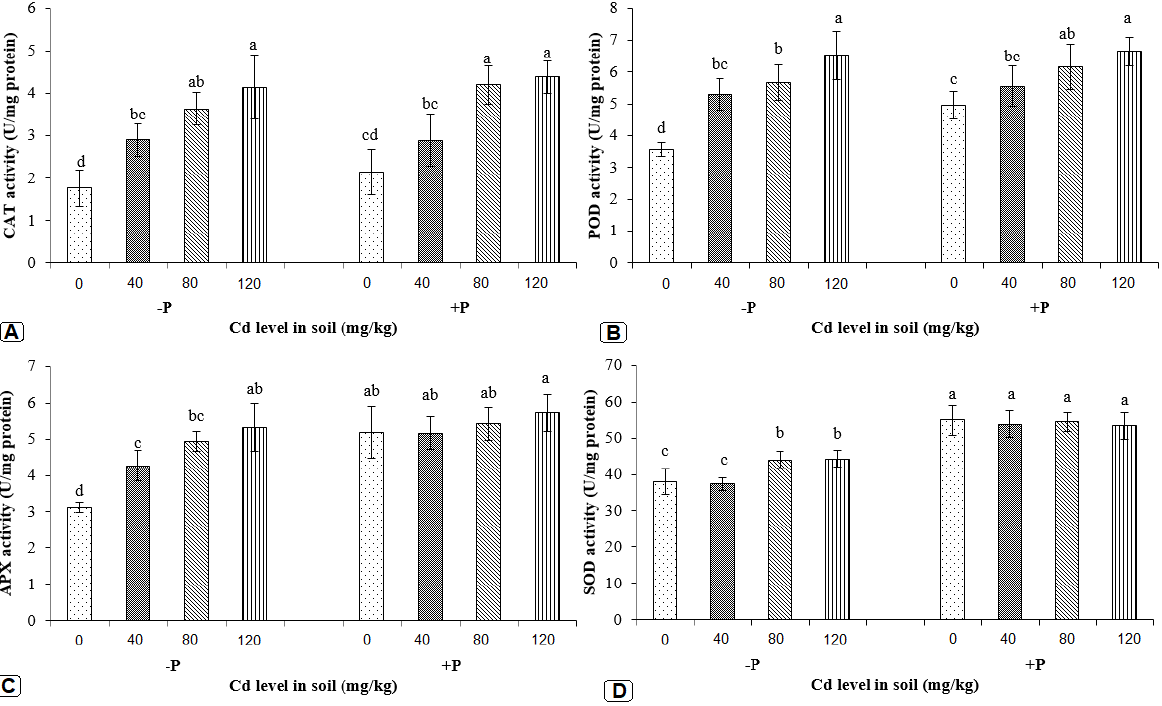
Fig. 6. The effect of P. indica on enzyme activities of A) CAT; B) POD; C) APX and D) SOD in sunflower leaves under different Cd concentrations in soil. P: P. indica. Values are mean ± SD; n = 5. The same letter within each column indicates no significant difference among treatments using Duncan’s Multiple Range Test at P <